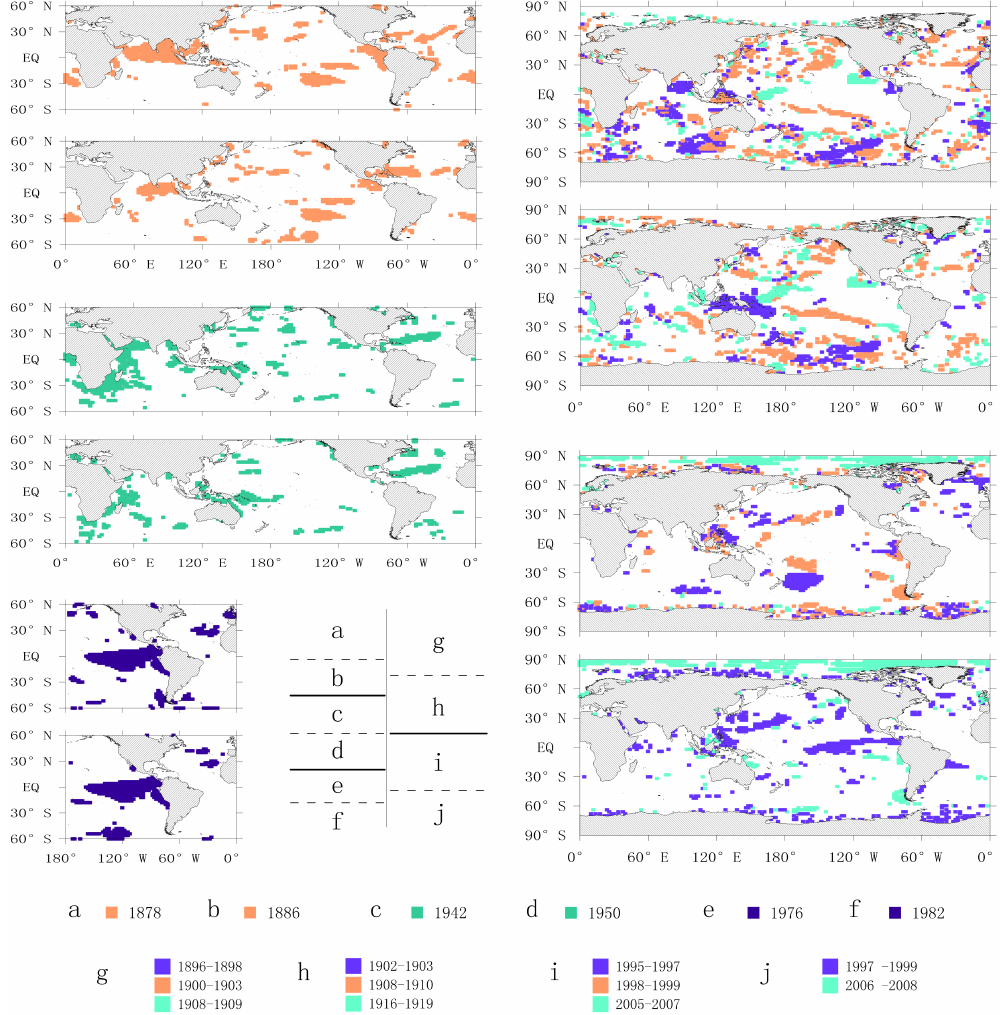
Figure 2. Spatial distribution classified based on frequency of start and end moments of abrupt change. (a) and (b) are the climate changes starting in 1878 and ending in 1886. (c) and (d) are the climate changes starting in 1942 and ending in 1950. (e) and (f) are the climate changes starting in 1976 and ending in 1982. (g) and (h) are the climate changes starting in 1890–1920 and ending in 1990–2010. (i) and (j) are the climate changes starting in 1990–2010 and ending in